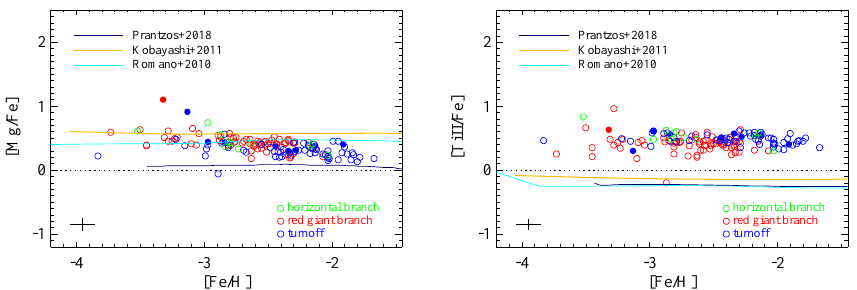
Figure 1. Abundance ratios ([Mg / Fe] and [Ti / Fe]) as a function of [Fe / H]. Red and blue circles indicate the abundance results for red giants and main-sequence turn-o ff stars, respectively [14]. Predictions of the three chemical evolution models [20–22] are shown by lines as presented in the